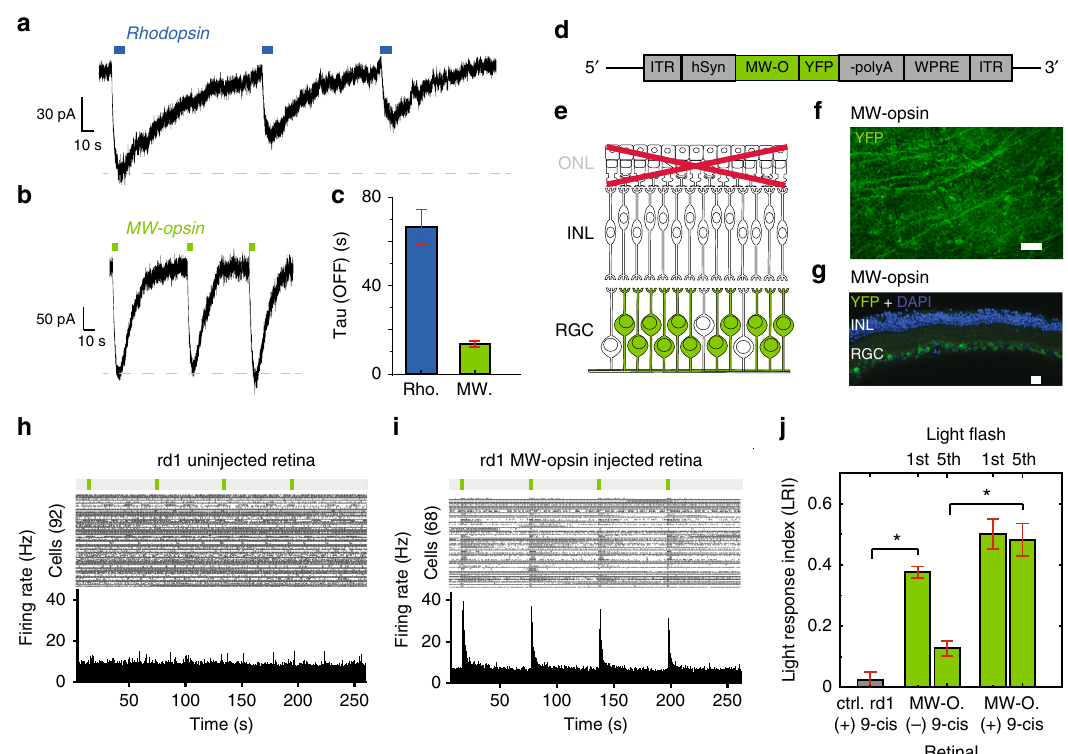
Fig. 1 Expression and function of MW-opsin in HEK293 cells and RGCs of rd1 mouse retina. a , b Representative traces of activation of homotetramer GIRK (F137S) channels by photo-stimulation of rhodopsin ( a ) or MW-opsin ( b ) measured in whole cell patch in 50 mM [K + ] ext at V H = − 80 mV in response to low intensity (1 mW cm − 2 ) pulses of light at 535 nm (for MW-opsin) or 500 nm (for rhodopsin). c Decay of photo-response (Tau OFF) for rhodopsin (blue) and MW-opsin (green). Values are mean + SEM; n = 6 (rhodopsin), 8 (MW-opsin) cells. d Viral DNA expression cassette. MW-opsin with YFP (green) under control of hSyn-1 promoter. e Schematic of a degenerated rd1 mouse retina with targeted RGCs highlighted (green). ONL outer nuclear layer, IPL inner plexiform layer. Photoreceptor degeneration denoted in light gray and red cross. f , g En face view of fl at mount ( f ) and transverse slice ( g ) confocal images of MW-opsin expression of rd1 mouse retina 4 weeks after intravitreal injection of AAV2/2-hSyn-MW-opsin-YFP . Images of YFP fused to C-terminal end of MW-opsin (green) show pan-retinal distribution ( f ) in RGC layer in relation to DAPI staining of nuclei ( d , blue). Scales 60 μ m ( f ) and 20 μ m ( g ). h , i MEA recordings from representative uninjected control ( e ) and MW-opsin expressing ( f ) rd1 mouse retina. (Top) Raster plot with spikes for each RGC ( e : n = 92 cells; g : n = 68 cells). (Bottom) Peristimulus time histogram (PSTH). Light stimulation protocol: 4 pulses of light of 100 ms duration ( λ = 535 nm, enlarged green bars) separated by 60 s dark intervals. j Normalized Light response Index (LRI) for rd1 retina without (gray) and with MW- opsin expression (green) (gray: N = 6 retinas, n = 295 cells; green: N = 8 retinas, n = 323 cells). LRI for 1st and 5th light fl ash without ( N = 3 retinas, n = 106 cells) and with ( N = 6 retinas, n = 257 cells) 9-cis retinal. Light intensity 2 mW cm − 2 . Wavelength: λ = 535 nm (MW-opsin), Values are mean + SEM. Cells are sorted units. Statistical signi fi cance assessed using Mann – Whitney U test (* p ≤